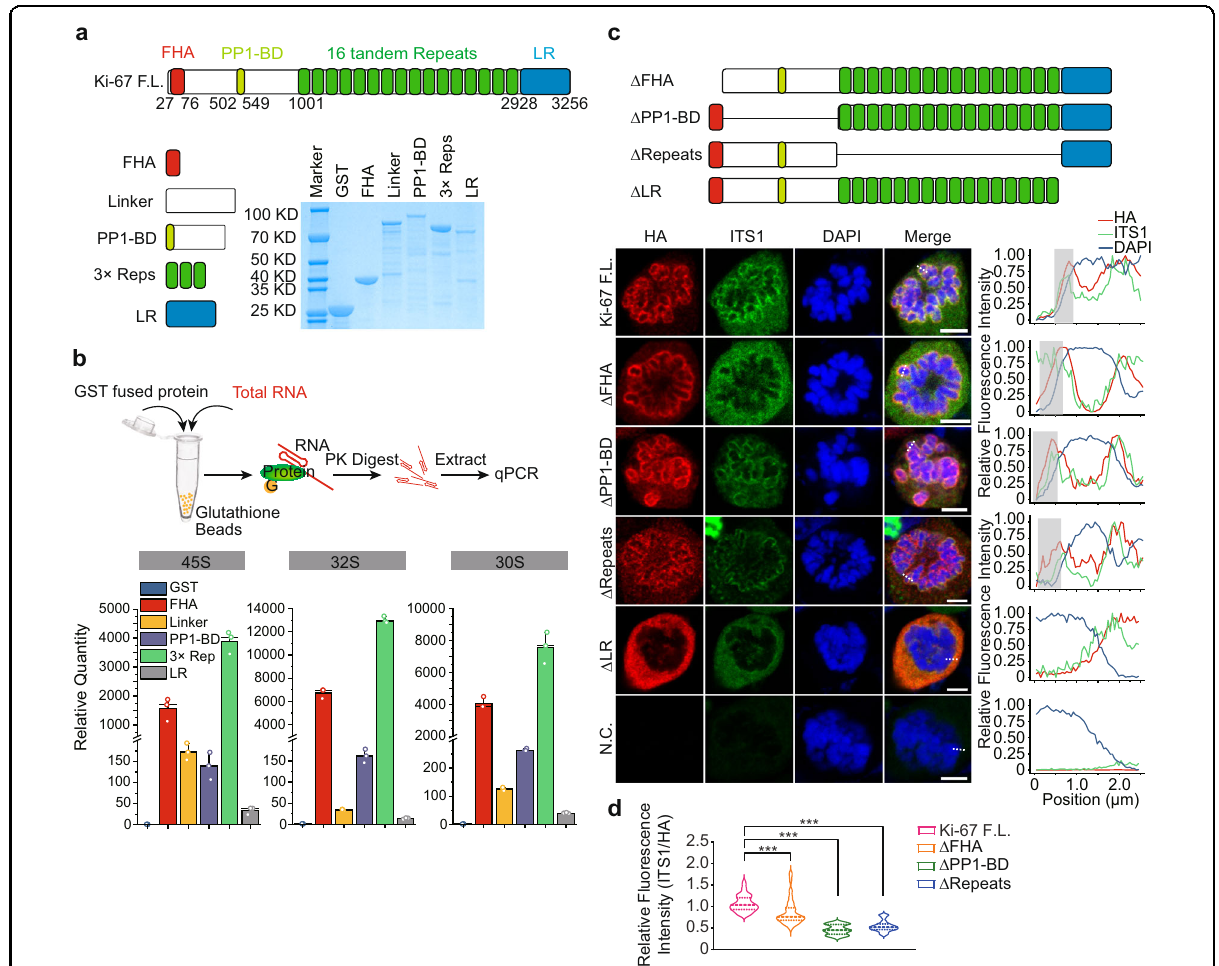
Fig. 5 Mapping the domains of Ki-67 interacting with pre-rRNAs. a A schematic diagram of each domain of Ki-67. Recombinant proteins of each domain were examined by Coomassie brilliant blue (CBB). b Ki-67 associates with rRNA. Upper panel shows the work fl ow of protein pulling down assays. Recombinant proteins were incubated with total RNA. The RNA pull-down assays were performed followed by RT-qPCR analyses. The location of primers is shown in Supplementary Fig. S1e. c Ki-67 plays an important role in chromosome dispersion. Upper panel shows a schematic diagram of internal deletion mutants of Ki-67. Lower left panel shows the chromosome dispersion in the Ki-67-de fi cient cells reconstituted with full-length and mutant Ki-67. RNA FISH was detected by Cy3-labeled probe against ITS1 region, HA-tagged full-length, and truncations of Ki-67 were detected by anti-HA antibody. Lower right panel is the line analysis of the pre-rRNA, Ki-67, and DAPI signal intensity at the indicated section. Scale bar, 5 μ m. d Statistic analysis of the relative fl uorescence intensity of ITS1 probe along the chromosome. The results were normalized by Ki-67 expression (the signal intensity of HA tag). *** P <